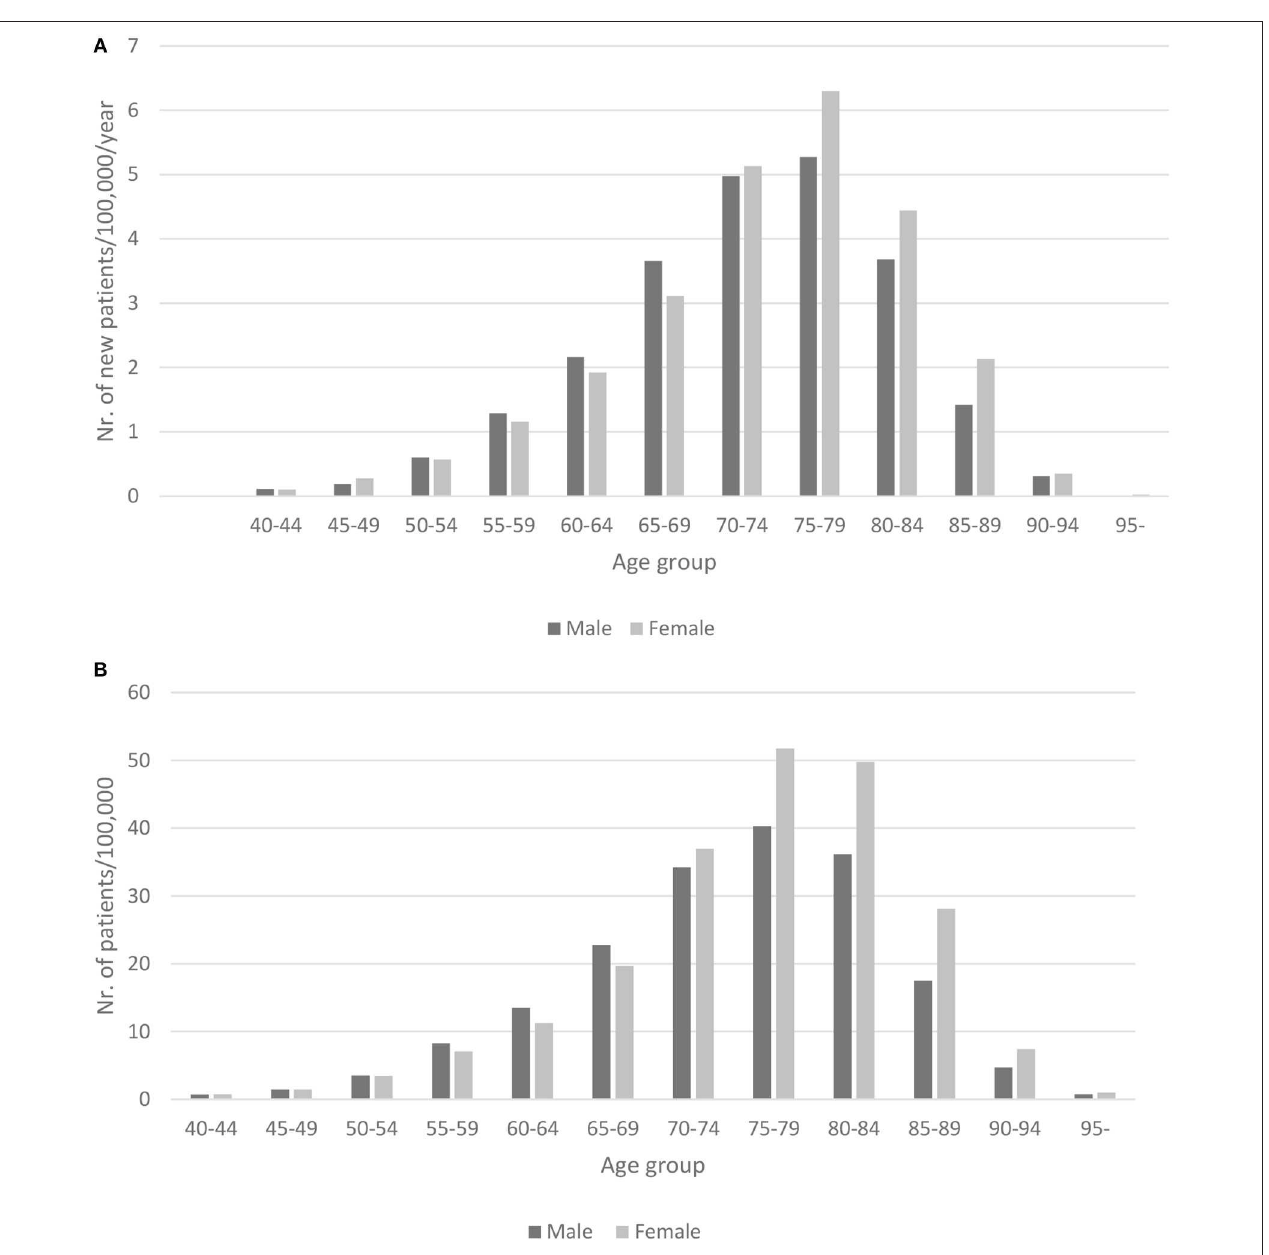
FIGURE 1 | (A) Crude incidence of PD in Hungary between 2010 and 2012 (per 100,000/year) by 5 year age categories and gender. (B) Crude prevalence of PD in Hungary between 2010 and 2012 (per 100,000) by 5 year age categories and gender.